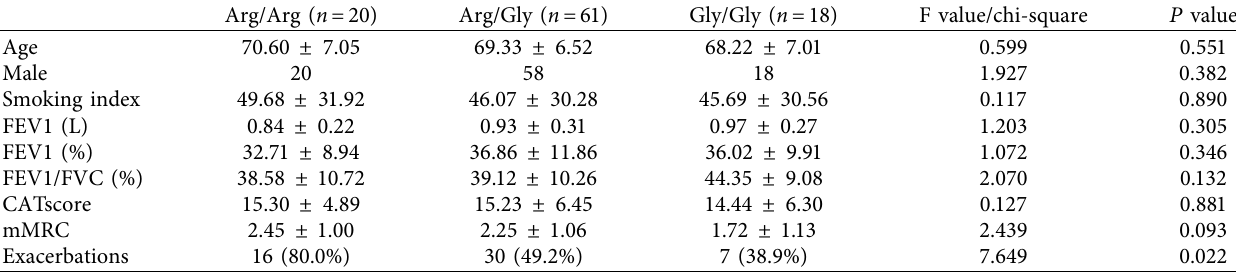
Table 1: Comparison of clinical characteristics of different genotypes.